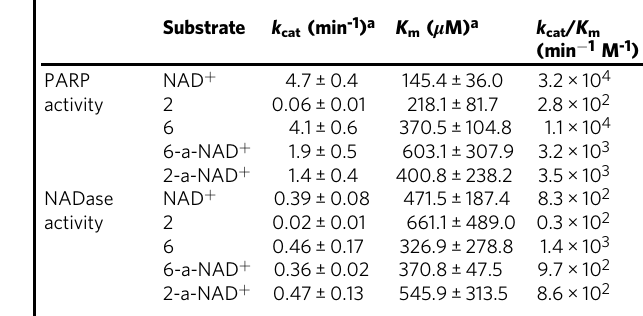
Table 1 Kinetic parameters of NAD + and its analogues for human PARP1